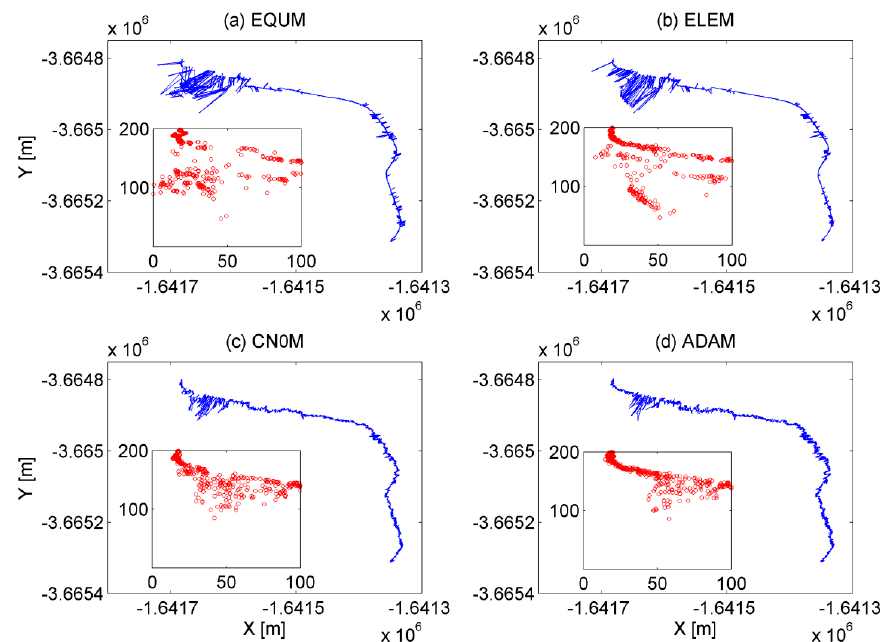
Figure 16. SPP results (blue lines) of dataset no. 3, where the horizontal and vertical coordinates denote the X and Y directions in WGS84 coordinate system respectively, and the detailed results (red points) in meter when the test receiver is located between EEEL and ES buildings. ( a ) Results of the equal-weight model (EQUM); ( b ) results of the elevation model (ELEM); ( c ) results of the C/N0 model (CN0M); and ( d ) results of the adaptive model (ADAM).